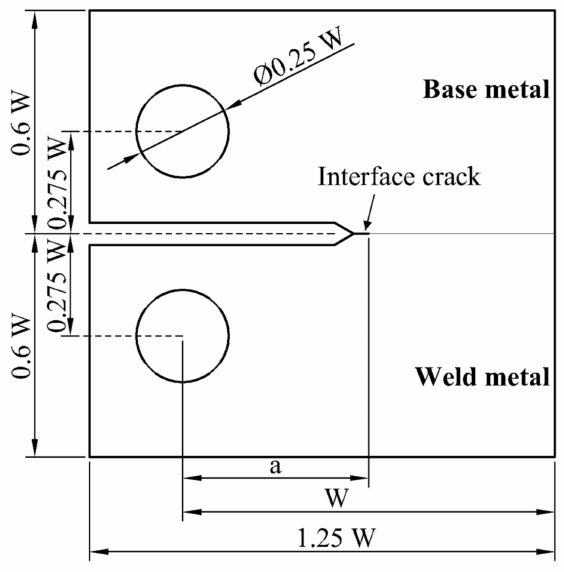
Figure 1. Geometry of 1T-CT